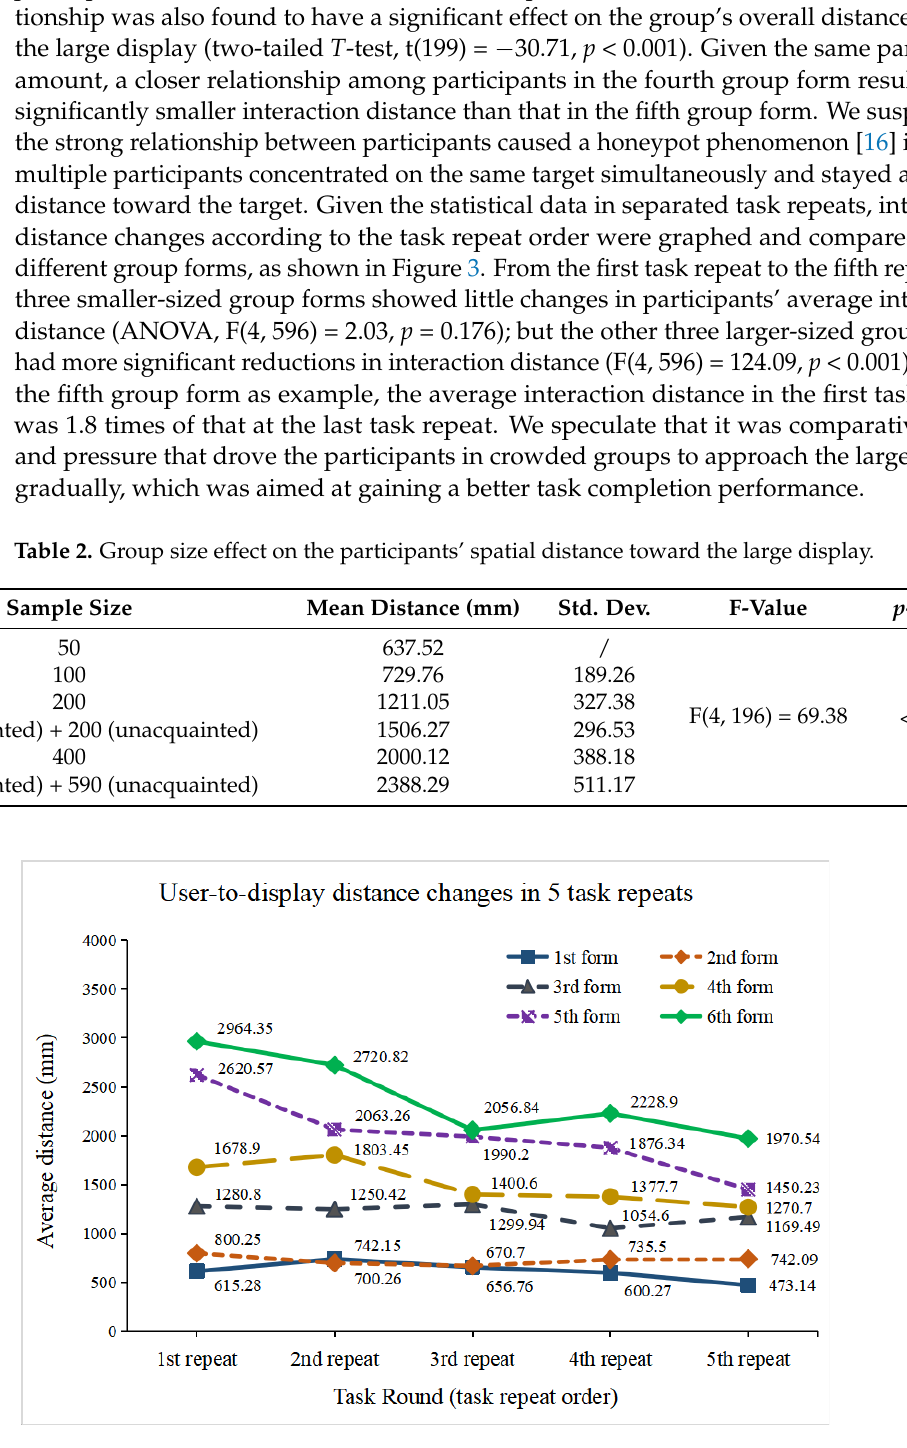
Figure 3. Interaction distance changes in 5 task repeats across 6 different group forms.